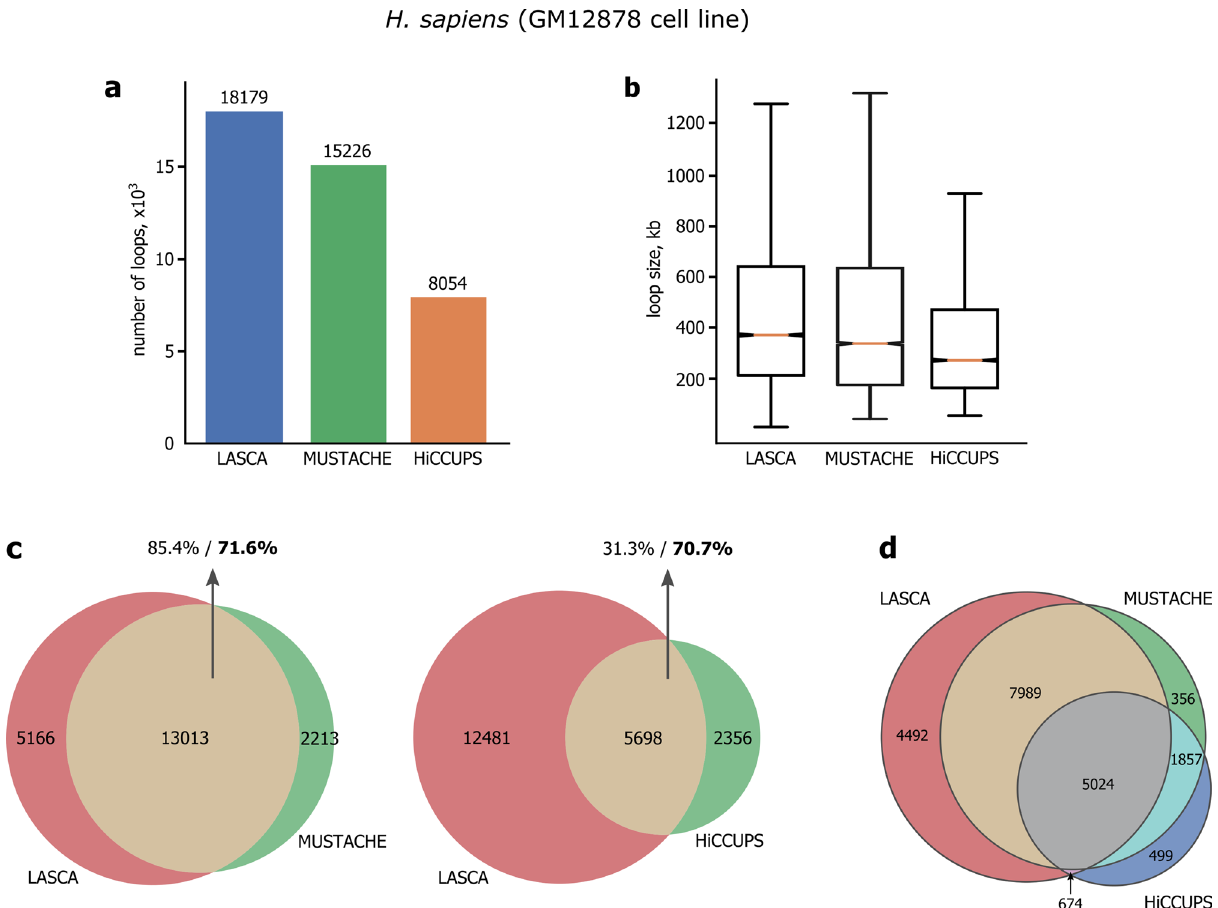
Figure 4. Comparison of LASCA pipeline with HiCCUPS and MUSTACHE. ( a ) Number of loops identified by LASCA, HiCCUPS and MUSTACHE in human Hi-C datasets (GM12878 cell line). ( b ) Sizes of loops identified by LASCA, HiCCUPS and MUSTACHE in GM12878 cells. Horizontal lines represent the median; upper and lower ends of boxplot show the upper and lower quartiles, the whiskers indicate the upper and lower fences. ( c ) The agreement between LASCA and MUSTACHE, and LASCA and HiCCUPS loops is shown as Venn diagrams. The overlap between the two loop sets is shown in yellow, and the percentages of overlap with respect to each set are reported separately. ( d ) Triple Venn diagram showing the intersection of loop sets identified by LASCA, MUSTACHE and